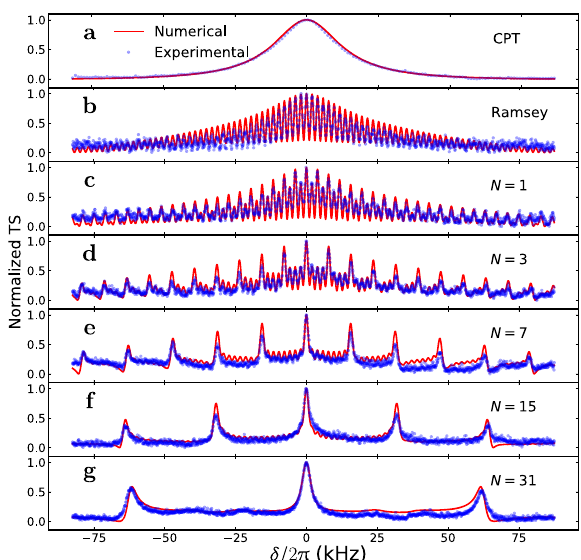
Fig. 3 Experimental transmission signals (TSs) for different schemes. a A Lorentz fi tting of single-pulse CPT spectrum shows a full width at half maximum (FWHM) is 27 kHz. b Conventional CPT- Ramsey spectrum is obtained with an integration time of 0.5 ms. c – g Multi-pulse CPT-Ramsey spectra of N equidistant pulses with a length τ = 2 μ s into the integration time of 0.5